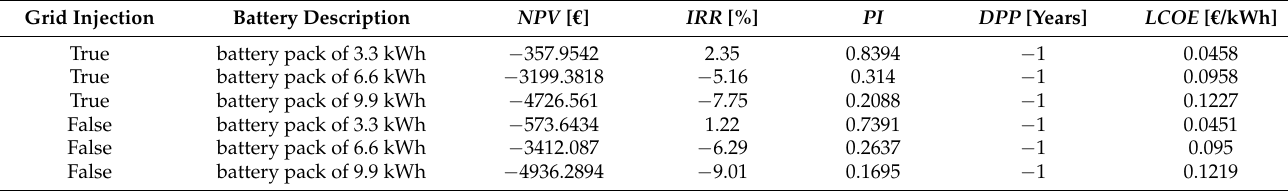
Table 11. Economical results for 0.75 kWp PV setup (individual battery